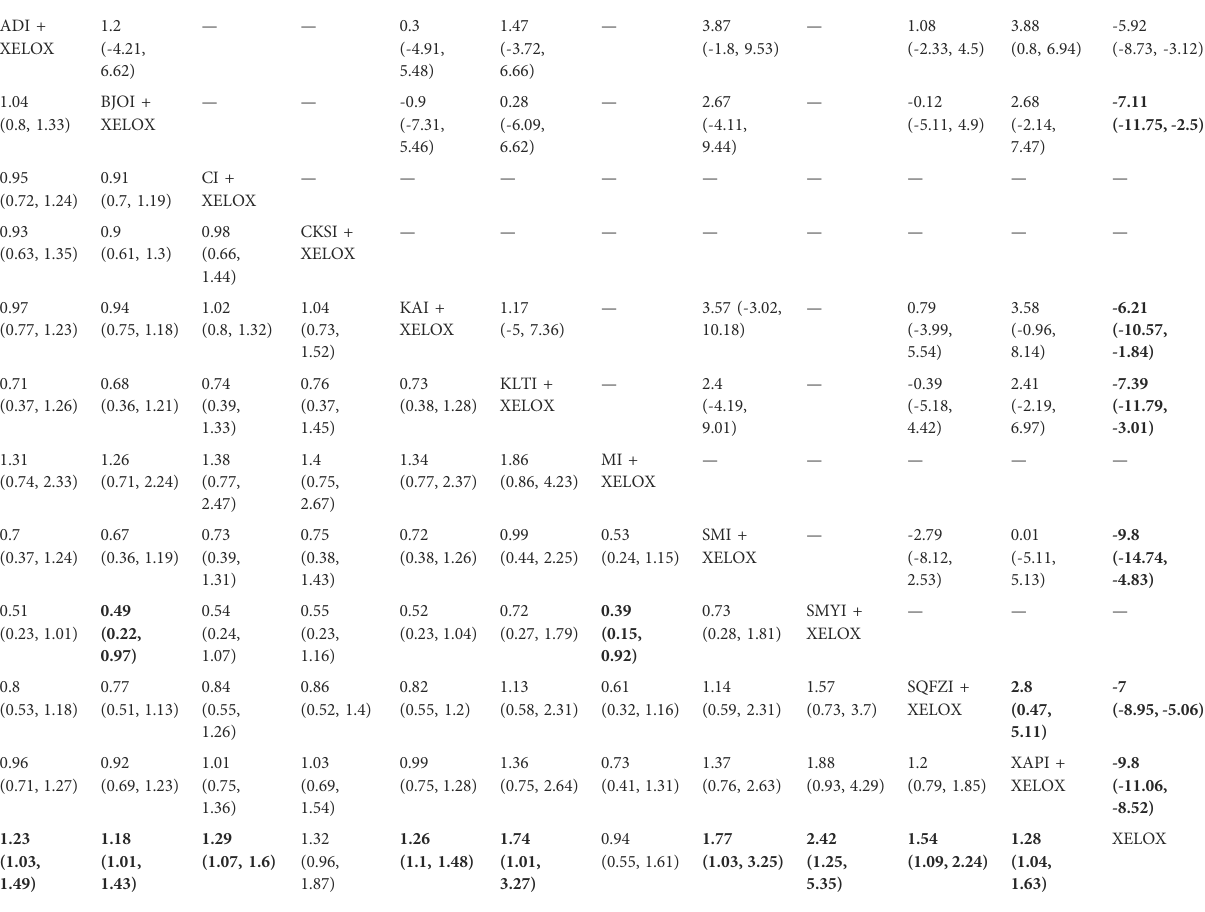
TABLE 2 Results of (MD/RR, 95% CI) Network Meta-Analysis for Improvement of Performance Status (Upper right section) and the Clinical Effective Rate (Lower left section). ADI + 1.2 XELOX